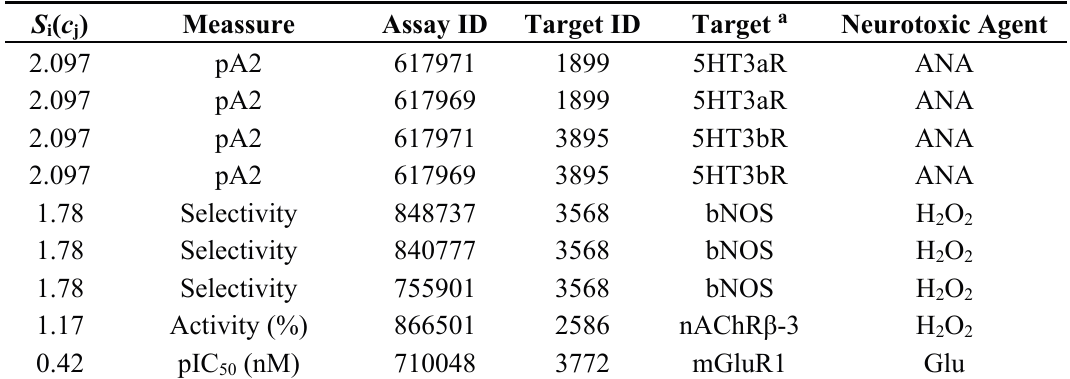
Table 6. Some predictive results for interaction between compound 6 with 5HT3Rs and other